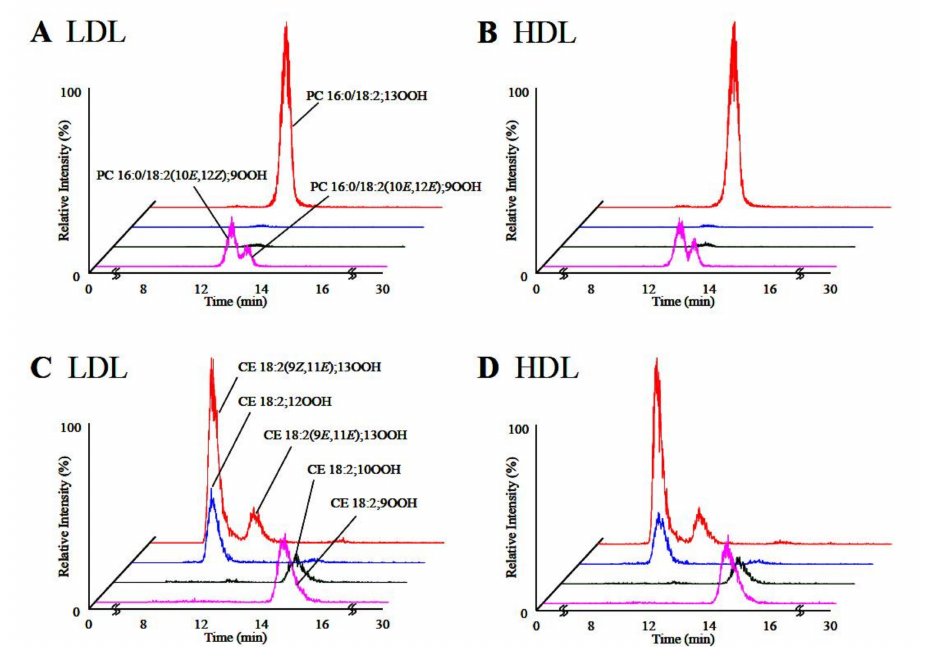
Figure 19. MRM chromatograms of PC 16:0/18:2;OOH isomers ( A , B ) and CE 18:2;OOH isomers ( C , D ). LOOH extracted from LDL ( A , C ) and HDL ( B , D )